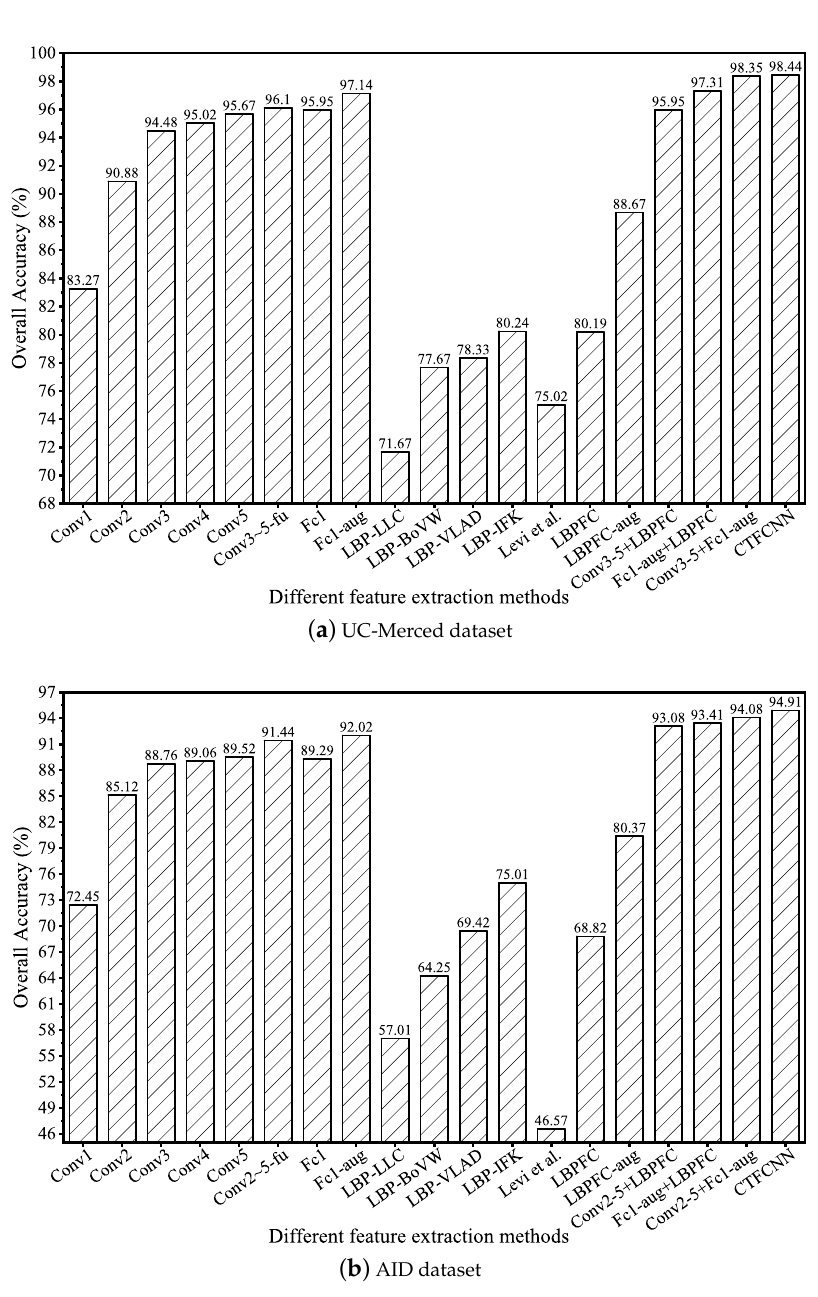
Figure 9. OAs of different feature extraction methods on two public